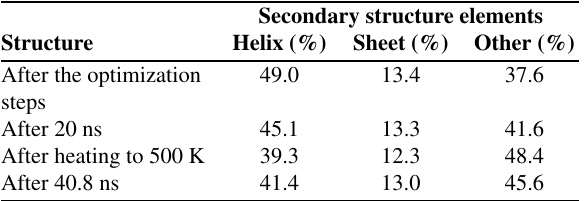
Table 3. Secondary structure elements calculated using »2Struc: the secondary structure server« (http://2struc.cryst.bbk.ac.uk/). 36 Secondary structure elements